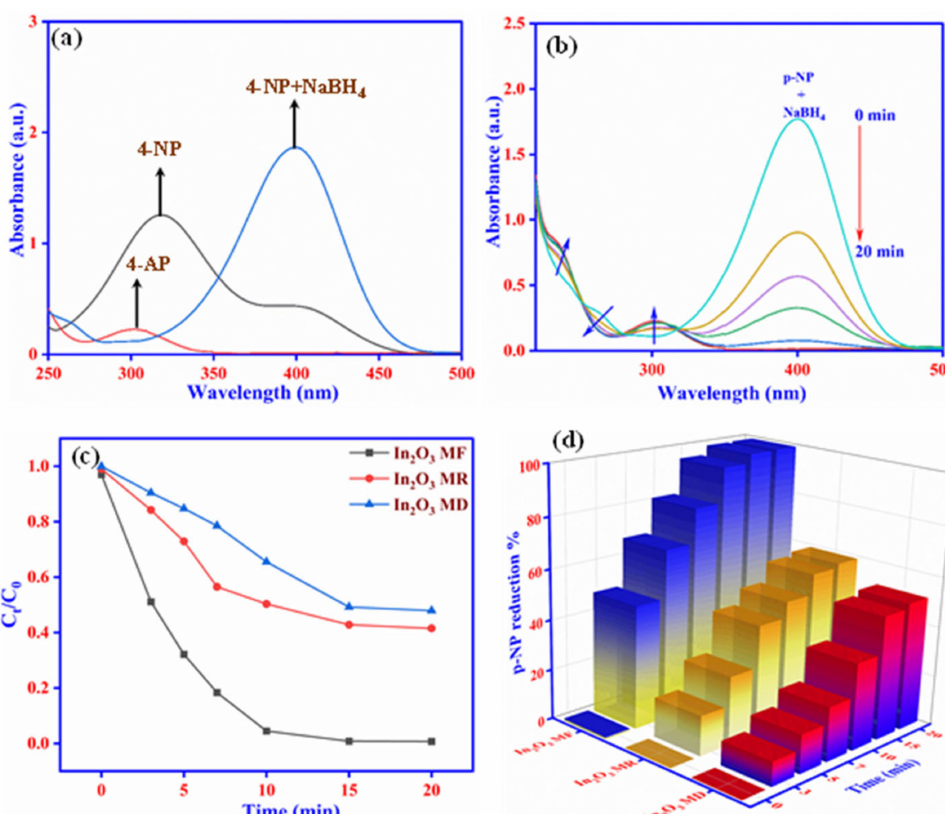
Figure 6. UV-vis spectra of 4-AP, 4-NP, and 4-NP with adding NaBH 4 ( a ); catalytic reduction of 4-NP using In 2 O 3 -MF as a catalyst ( b ); plots of C t /C 0 vs. contact time using In 2 O 3 -MF, In 2 O 3 -MR, and In 2 O 3 -MD catalysts ( c ), 4-NP reduction % vs. contact time plot ( d